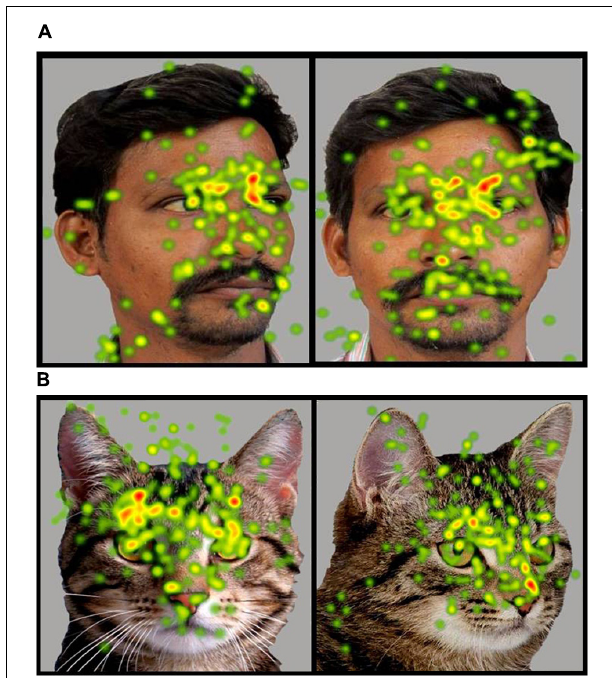
FIGURE 6 | (A,B) Heat Diagrams illustrating the most attended areas of the human and animal front and averted faces by ASD participants and indicating the greater visual attention to direct gaze in the animal face in ASD (Gradients of most attended areas on the heat maps range from red through yellow to green) . Permissions and image licenses have been obtained from the copyright holders (Source: ©Ermolaev